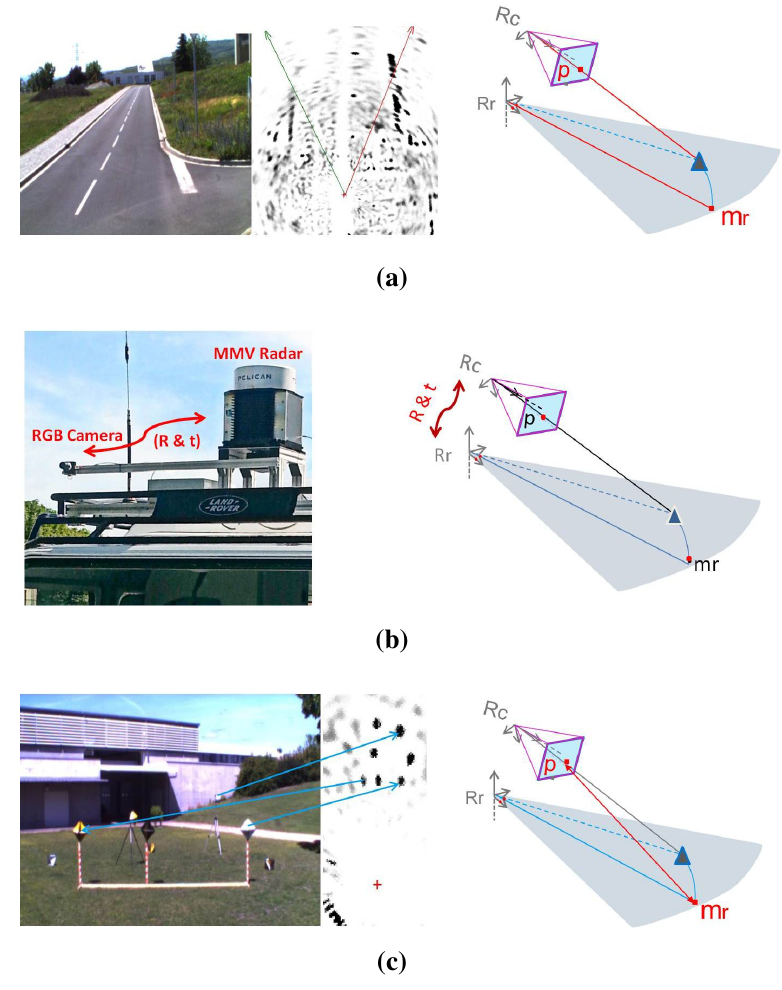
Figure 3. In order to achieve the 3D reconstruction, three preliminary steps must be carried out: simultaneous data acquisition by the sensors, the estimation of the transformation between the sensor frames and the extraction and matching of features from the camera image and the radar panoramic. ( a ) Data acquisition; ( b ) System calibration; ( c ) Features extraction and